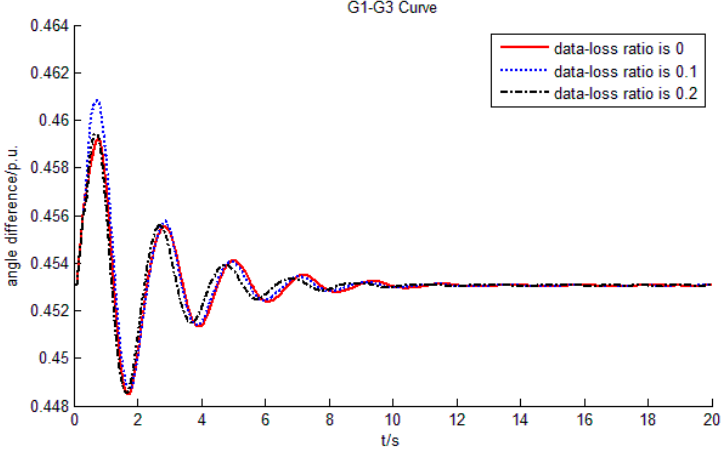
Energies 2018 , 11 , x FOR PEER REVIEW Figure 10. G1–G3 angle difference curves with different data-loss ratios. Figure 10. G1–G3 angle difference curves with different data-loss ratios.